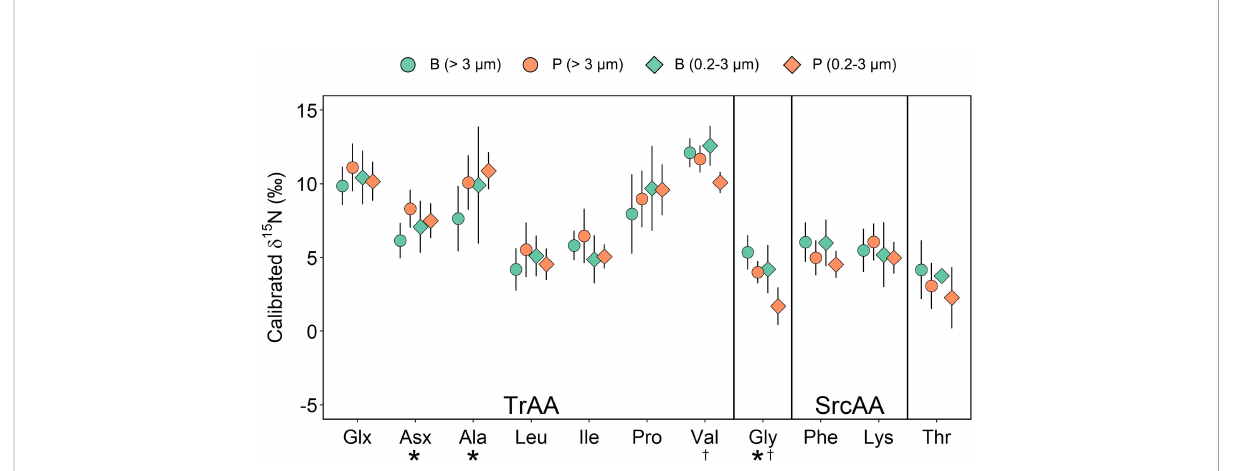
FIGURE 3 Normalized d 15 N-AA values of pelagic algae (P) and sea ice algae from the brash ice (B). Error bars show ±1 standard deviation for each group (n = 4-8). Asterisks indicate signi fi cant differences between > 3 m m sea ice and pelagic algae (Two Sample T-test, p < 0.05). Daggers indicate